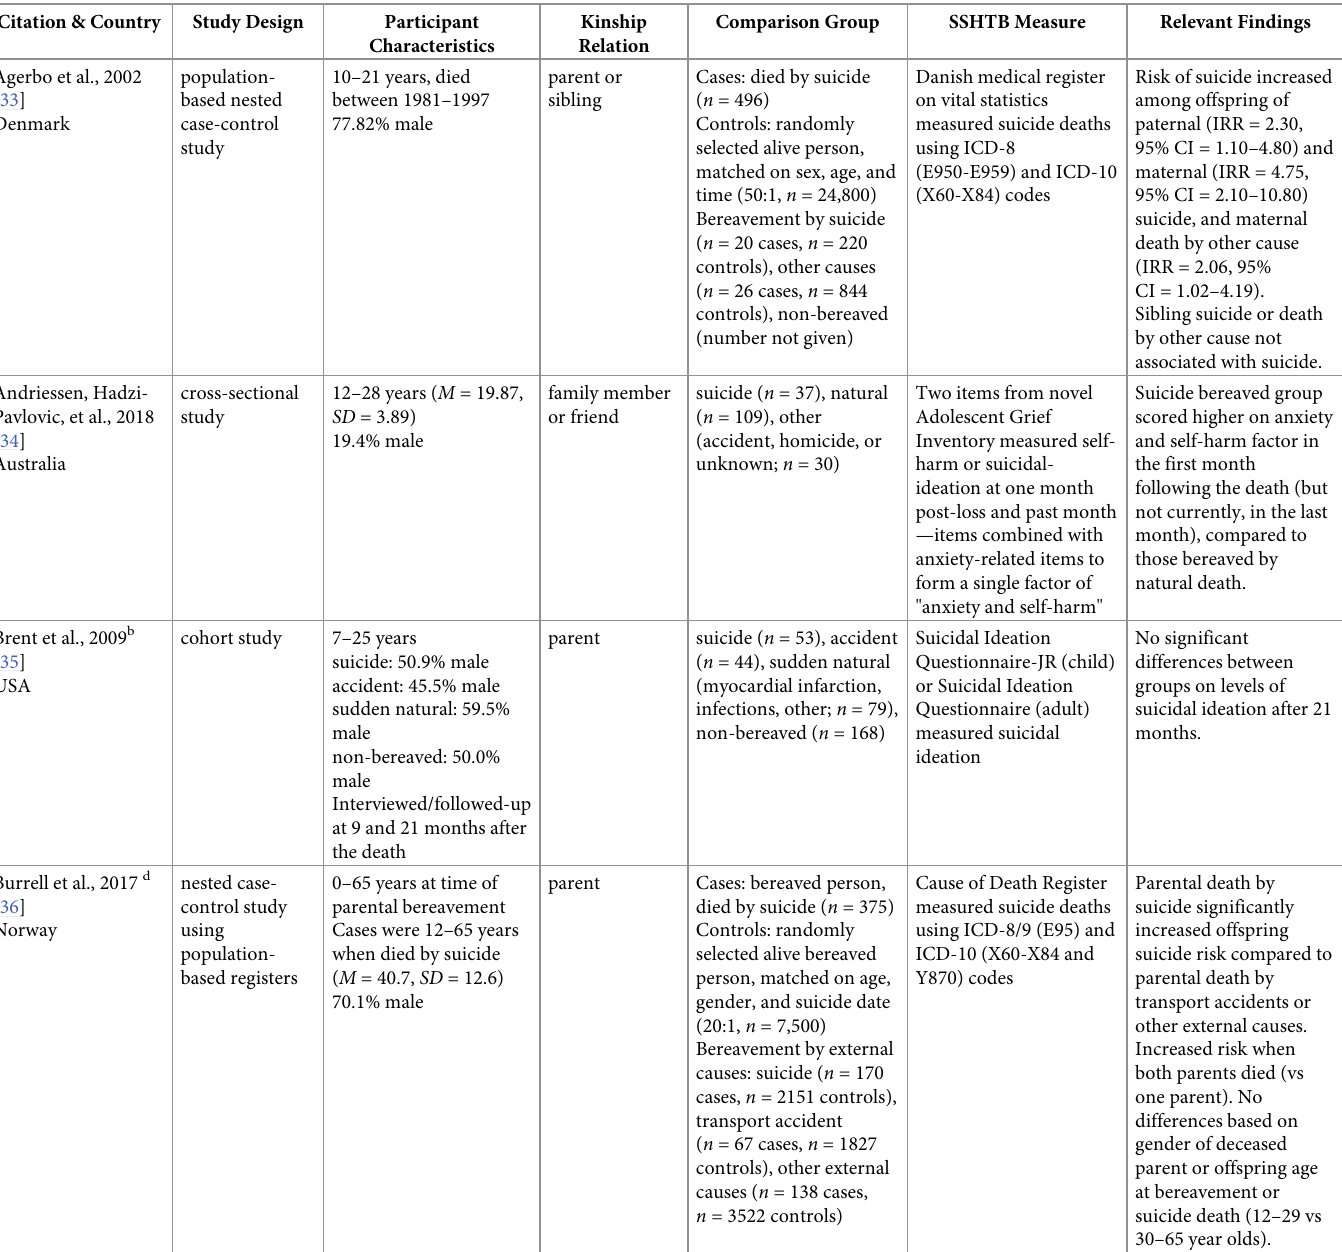
Table 1. Summary of studies included in the review. Citation &